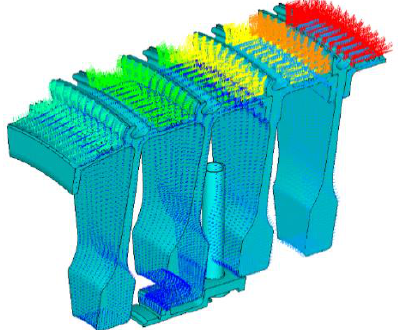
Figure 5. Pressure in the disk cavity.